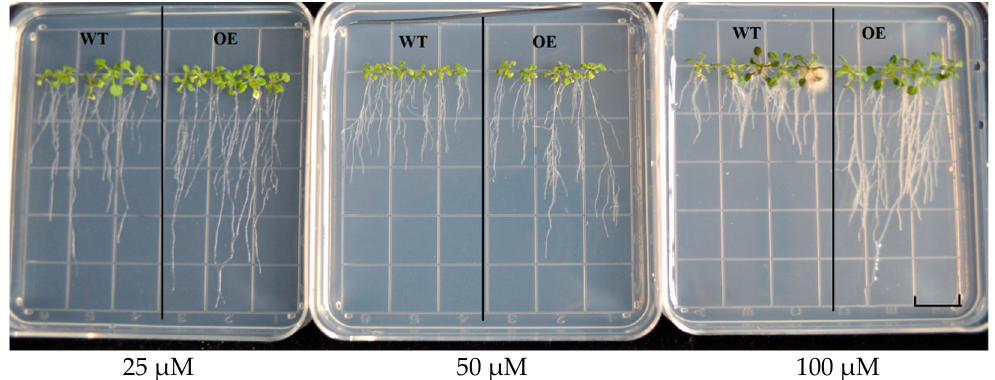
Figure 11. The phenotypic analysis of root length in wild type (WT) and transgenic Arabidopsis thaliana. WT represents the wild Arabidopsis thaliana , OE represents the transgenic Arabidopsis thaliana . Scale bars: 1.4 cm.